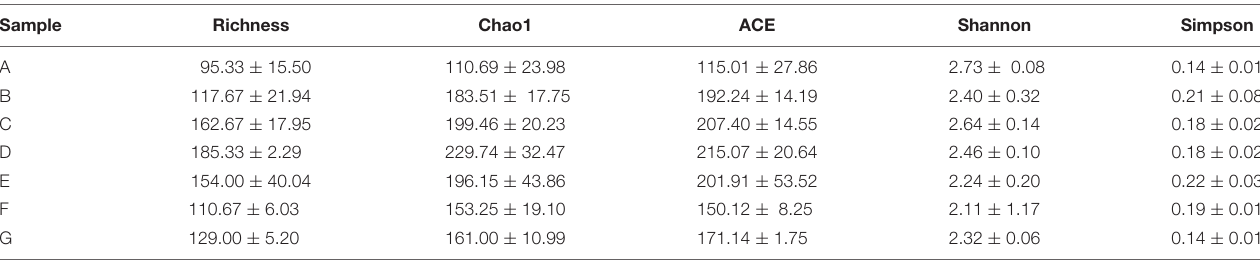
FIGURE 1 | Appearance changes of Cabernet Sauvignon grape at different growth stages. (A) before flowering; (B) fruit set; (C) berries pea size; (D) berries still hard and green; (E) the beginning of the berry ripening; (F) berries not quite ripe; (G) harvest ripe. TABLE 1 | Abundance and diversity indexes of fungi communities on the surface of wine grapes at seven different growth